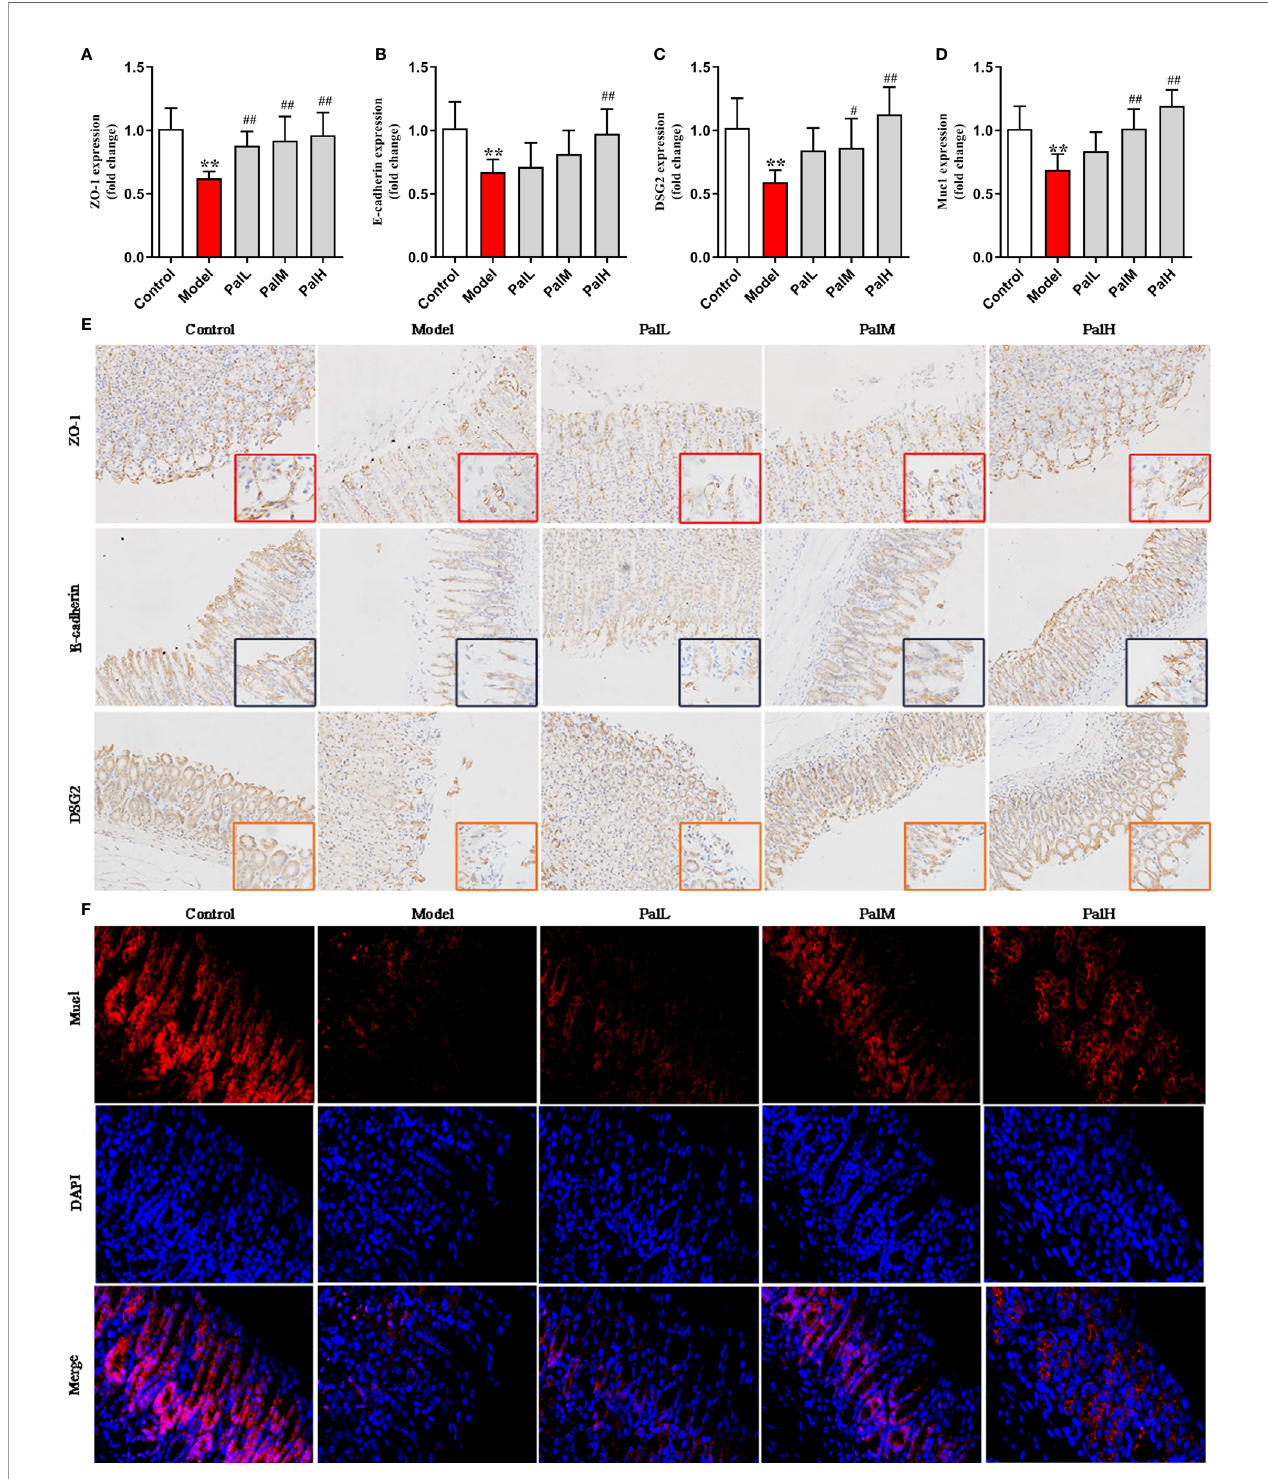
FIGURE 5 | Pal protected mucosal integrity by modulating epithelial junctions and mucins. (A – D) ZO-1 (A) , E-cadherin (B) , Desmoglein 2 (DSG 2) (C) and Muc1 (D) mRNA in gastric mucosa were analyzed by RT-PCR (n=6). (E) Representative immunohistochemical staining images in gastric mucosa showing ZO-1, E-cadherin, DSG2 expressing (200 × and 400 × magni fi cation). (F) Representative immuno fl uorescence staining images in gastric mucosa showing Muc1 expressing (400 × magni fi cation). ** P < 0.01 vs control group. # P < 0.05 and ## P < 0.01 vs model group. PalL (10 mg/kg); PalM: (20 mg/kg); PalH: (40